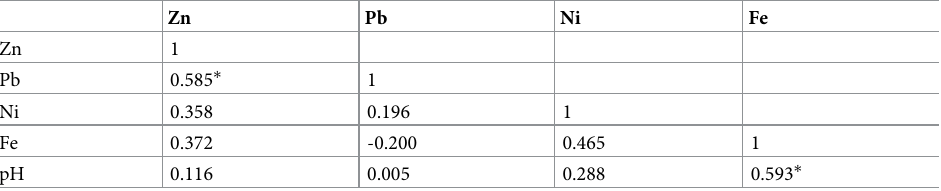
Table 3. Metal-to-metal correlation coefficient matrix for metals in sediment samples of river Bharalu. Zn Pb